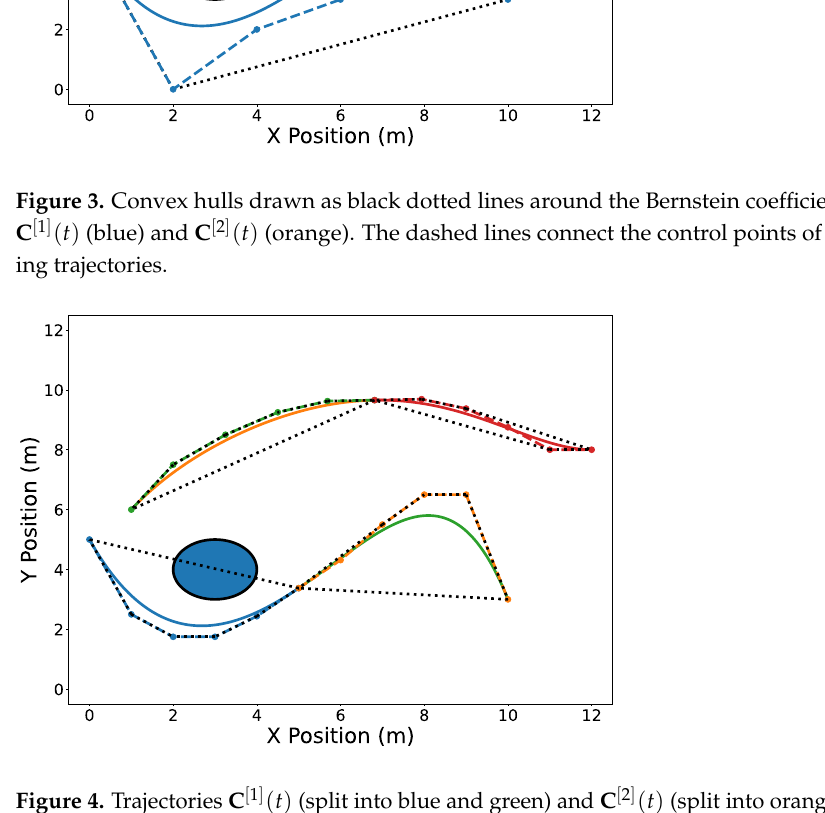
Figure 4. Trajectories C [ 1 ] ( t ) (split into blue and green) and C [ 2 ] ( t ) (split into orange and red) split at t div = 15 s. Convex hulls are drawn around the Bernstein coefficients of the new split trajectories.